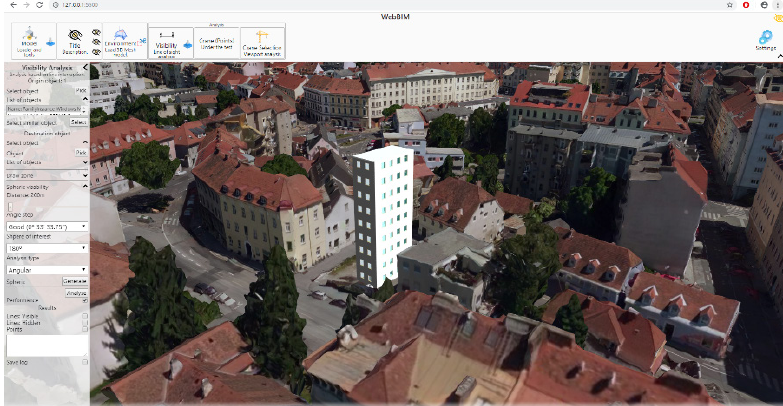
Figure 6. Implementation of the BIM model, GIS map, and real environment 3D mesh model inside the Web